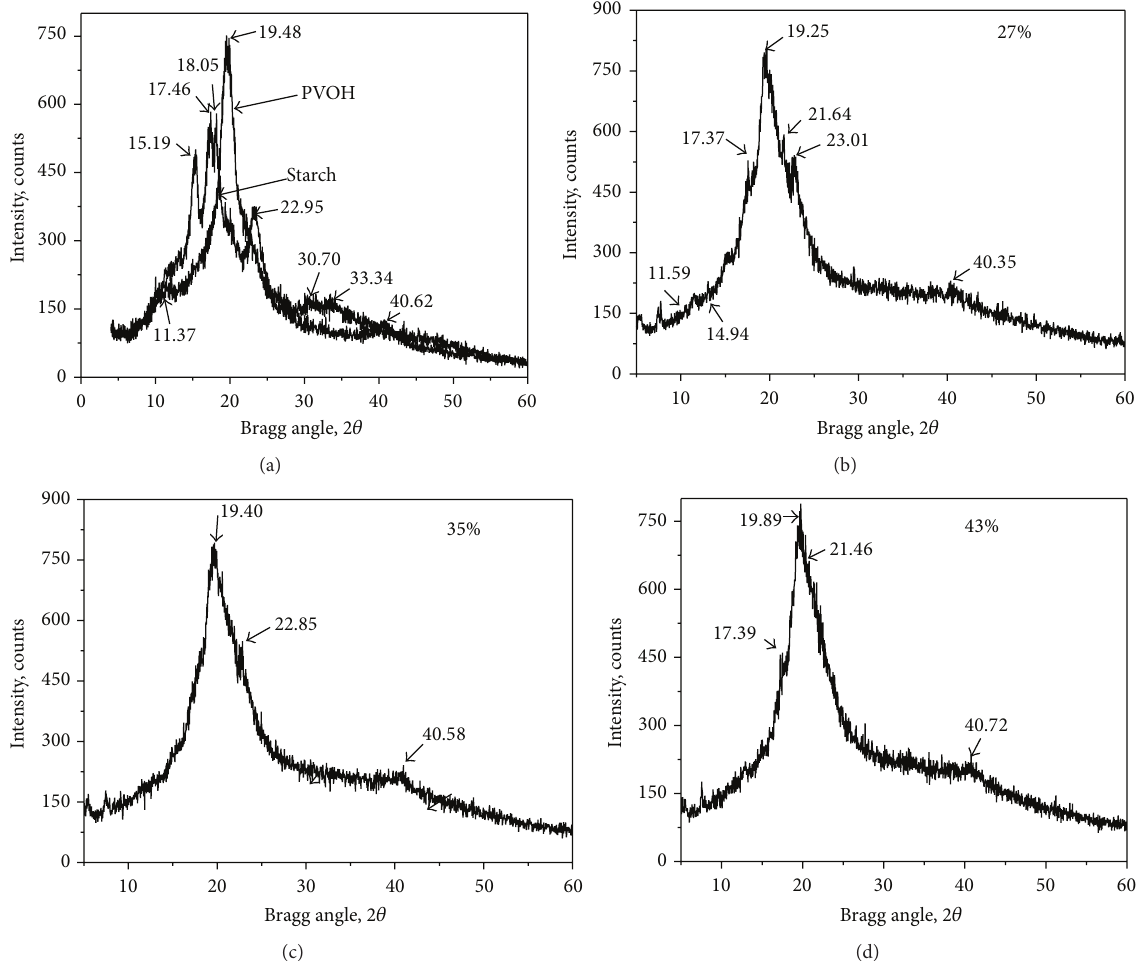
Figure 9: The diffractograms of studied blends (PVOH and starch (a); blends with plasticizing level of 27% (b); 35% (c); 43% (d)).